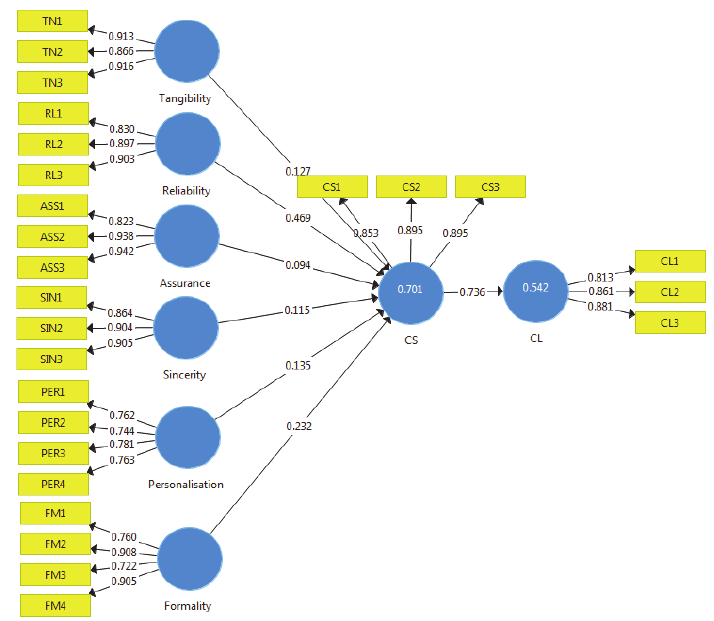
Fig. 2. Measurement